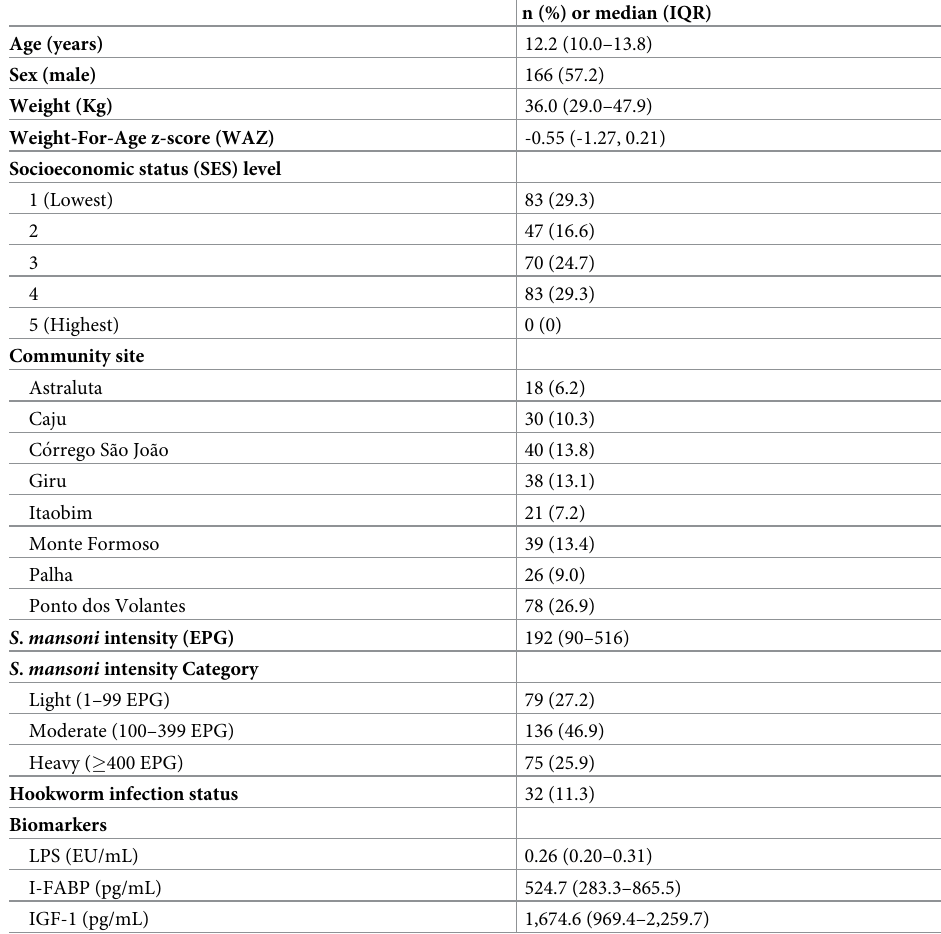
Table 1. Participant characteristics at baseline, N =